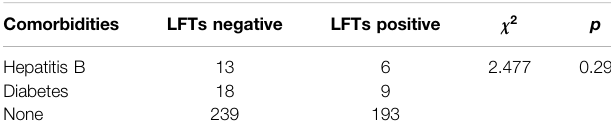
TABLE 8 | Liver function test results versus comorbidities among TB